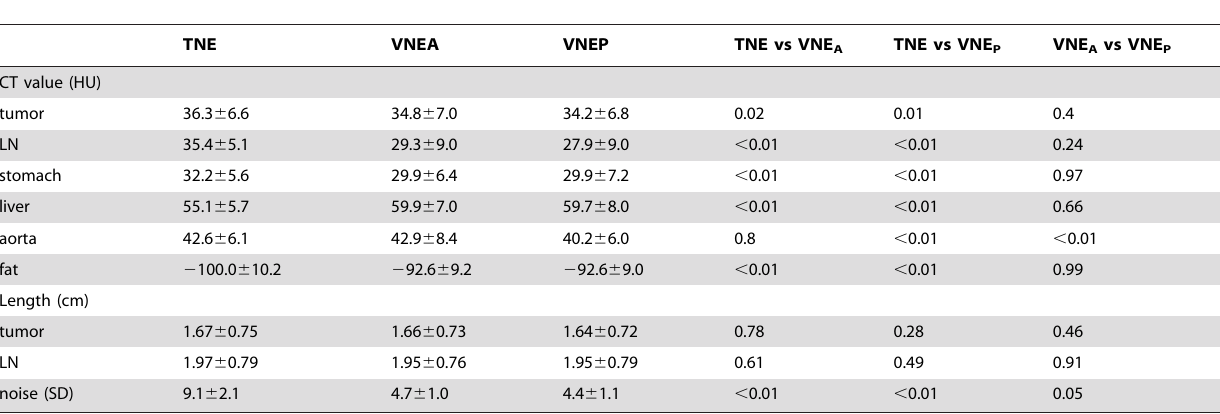
Table 1. Mean Length, CT value and noise of ROI measured in three series of non-enhanced